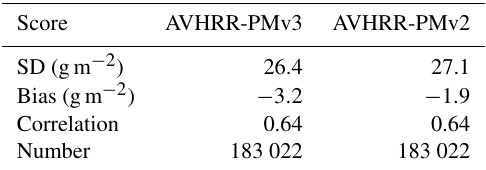
Table 5. Liquid water path (LWP) validation results for Cloud_cci AVHRR-PMv3 when compared with AMSR-E for the year 2008. Validation results for AVHRR-PMv2 for the same time period are also reported. Validation measures are standard deviation (SD) of the error, the mean error (bias) and correlation. In addition the num- ber of collocated pixels is